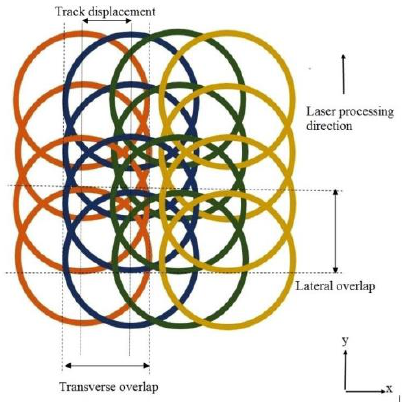
Figure 3. schematic diagram of pulsed laser scanning showing both the lateral and transverse overlaps for a typical 67% pulse overlap.